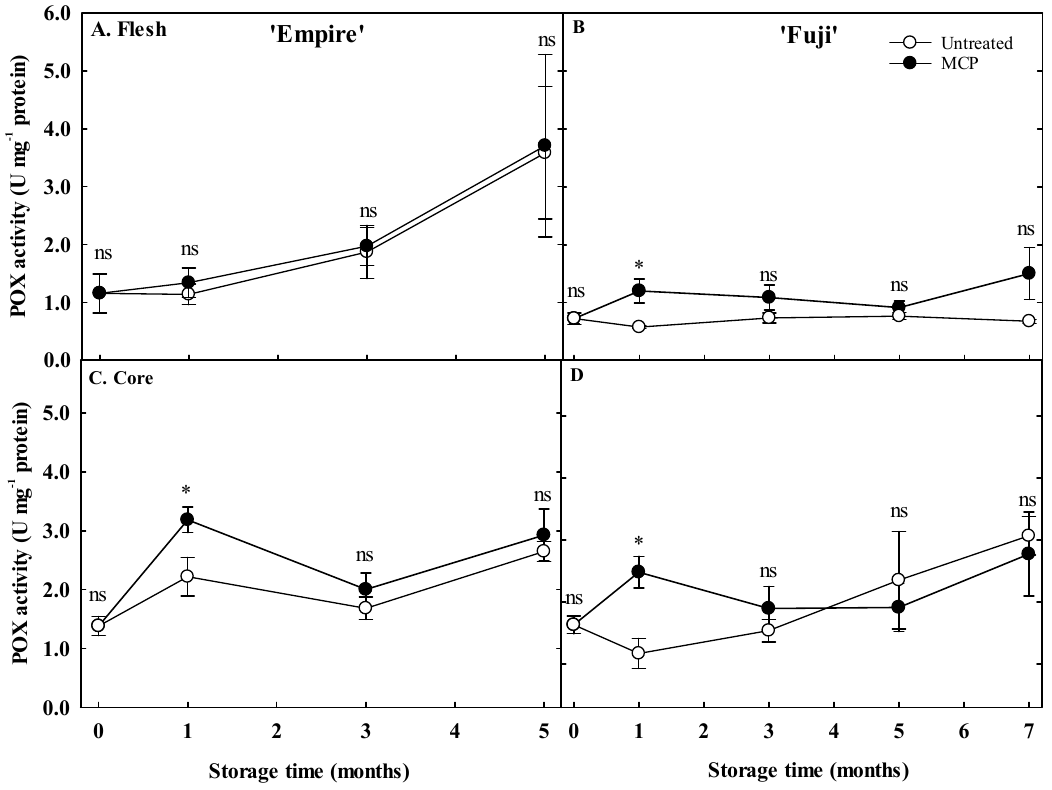
Figure 2. POX (Peroxidase) in flesh ( A , B ) and core tissue ( C , D ) on ‘Empire’ and ‘Fuji’, either untreated or treated with 1 µL·L − 1 1-MCP, and stored at 0.5 °C in air storage for up to five and seven months, respectively. Bars represent error of the means (S.E.M; n = 5) when larger than the dimension of the symbol. ns and * indicate non-significant and significant differences between untreated and 1-MCP treatments at p < 0.05, respectively.